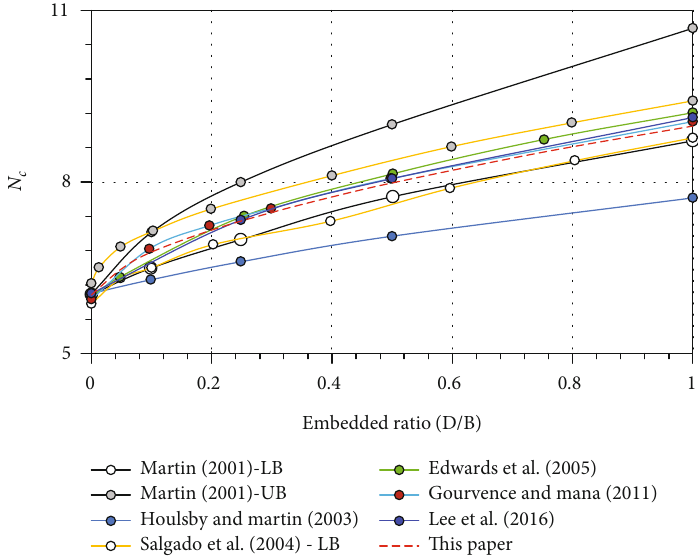
Figure 7: Variation curve of N